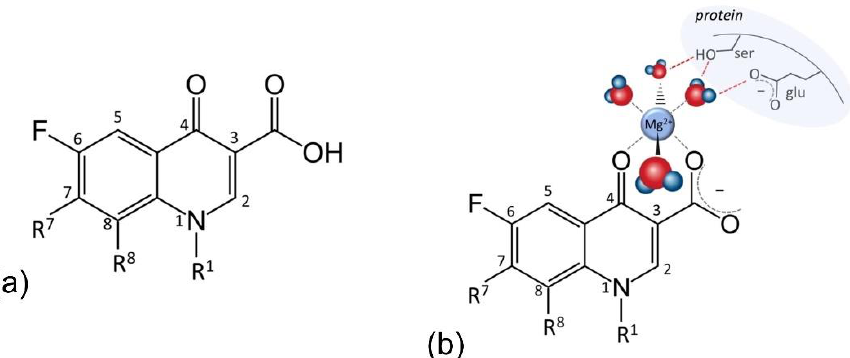
Figure 5. ( a ) General structure of fluoroquinolones. ( b ) Chelation of Mg 2+ by a fluoroquinolone molecule (moxifloxacin), as the core of their mode of action. Two water molecules serve as a bridge to bacterium topoisomerase IV (hydrogen bonds indicated by red dashed line), blocking phosphotyrosine from approaching the other Mg 2+ at the enzyme’s active site. Hydrogen bonds with DNA strand also present are not shown for simplicity. Inspired by ref. [45].